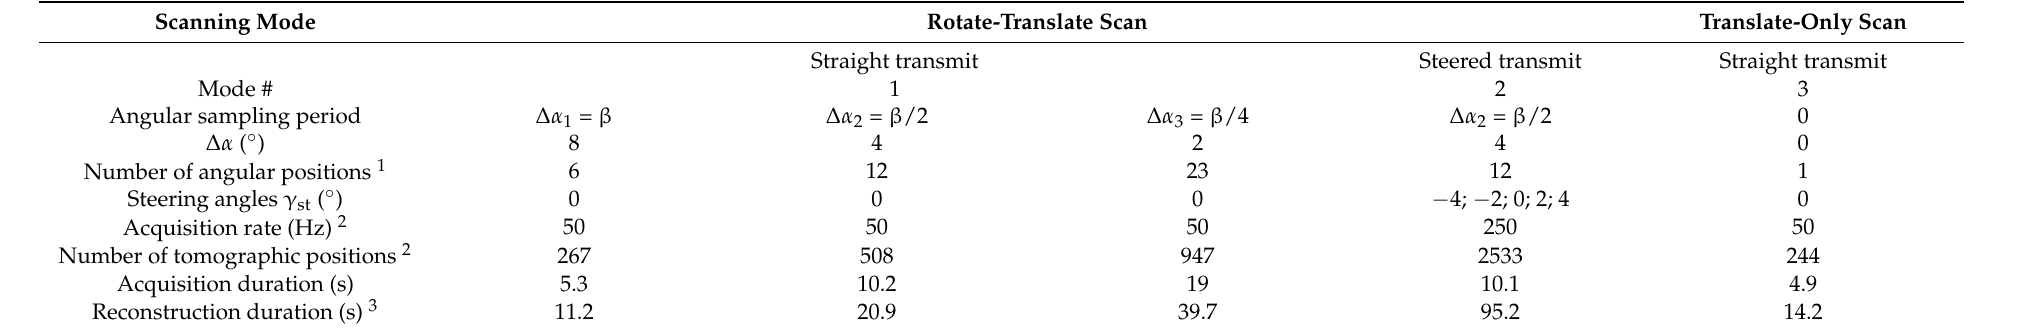
Table 1. Parameters of the different acquisition modes for a translation range L = 30